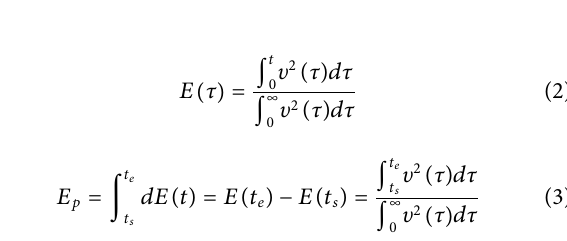
Frontiers in Earth Science |